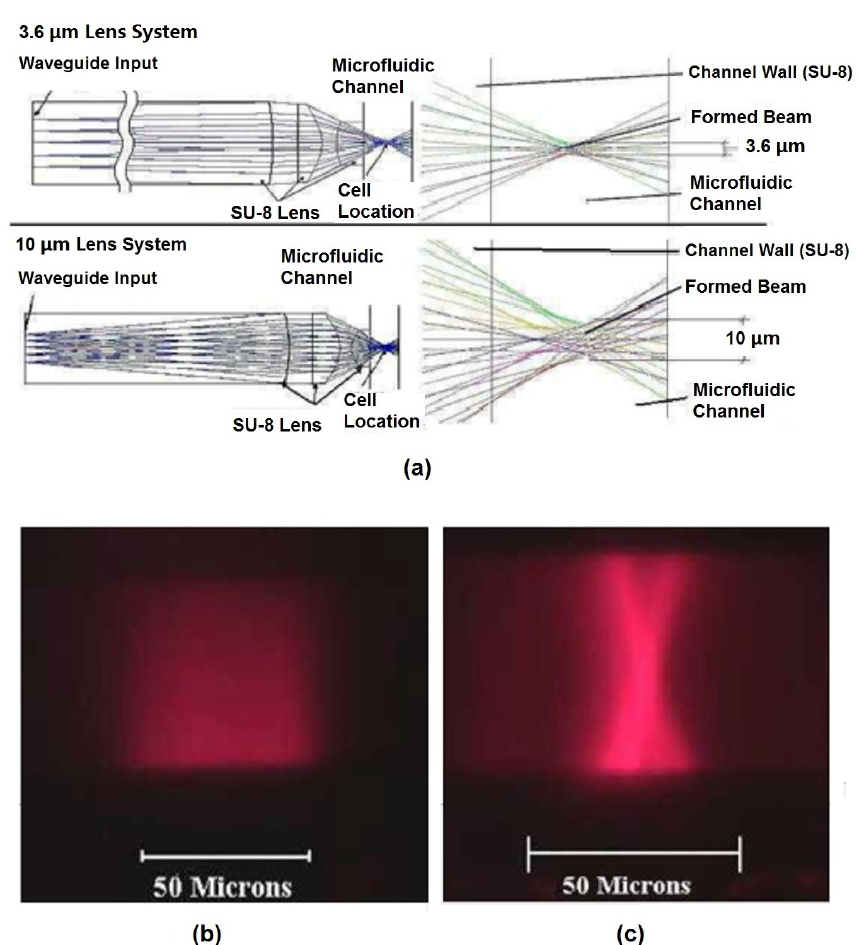
Figure 6. Beam shaping simulation results and fluorescent images of formed beam shape. ( a ) ZEMAX simulation results of 3.6-µm and 10-µm on-chip beam shaping lens systems. ( b ) Fluorescent image of the input excitation beam input directly from a waveguide without any lens. ( c ) Fluorescent image of formed beam shape after passing through a 10-µm beam shaping lens system. Reprinted from [67] with permission from OSA